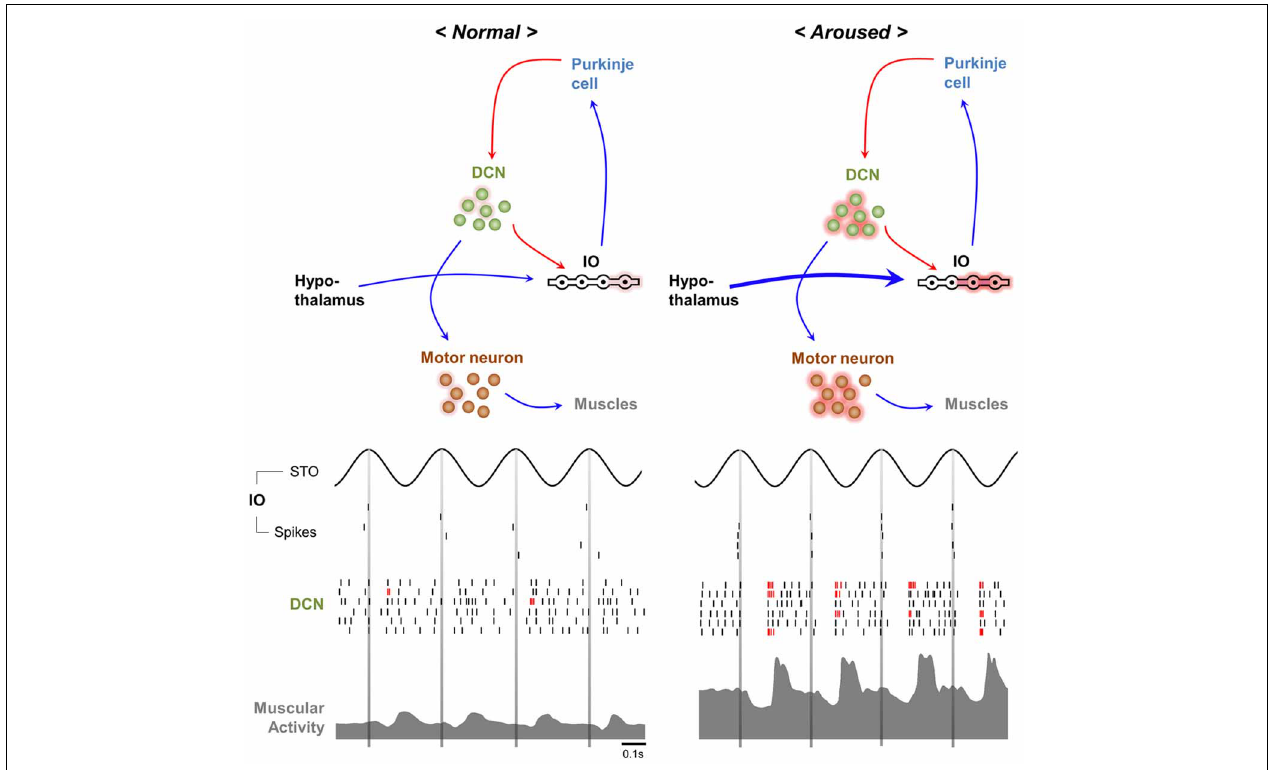
FIGURE 2 | Hypothetical mechanisms underlying normal and arousal-enhanced physiological tremors. Physiological tremor generation ( left ). Adjacent IO neurons share ∼ 10Hz STOs via gap junctions, which results in ∼ 10Hz rhythms in the population of cells. Action potentials propagate from IO neurons to Purkinje cells and then to the DCN, thereby causing inhibitory responses and then rebound excitation in DCN neurons.